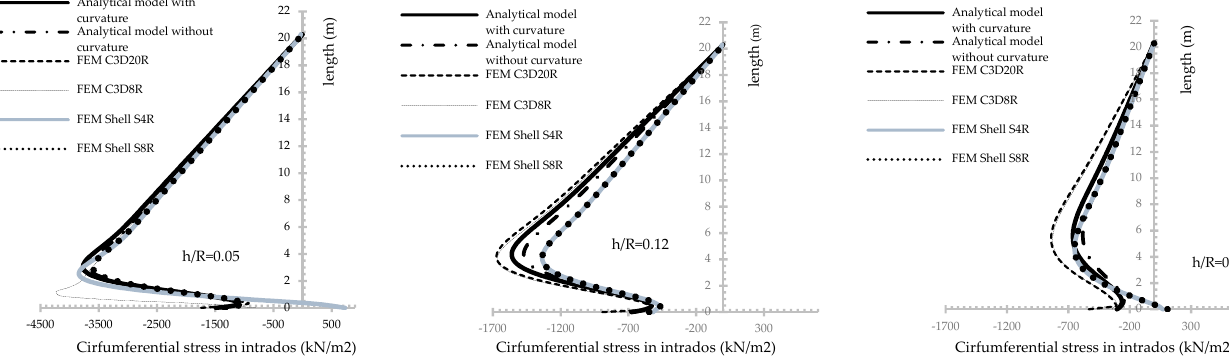
Figure 10. Longitudinal stress in intrados for thin, medium and thick shells, considering different models. Figure 11. Longitudinal stress in extrados for thin, medium and thick shells, considering different models.